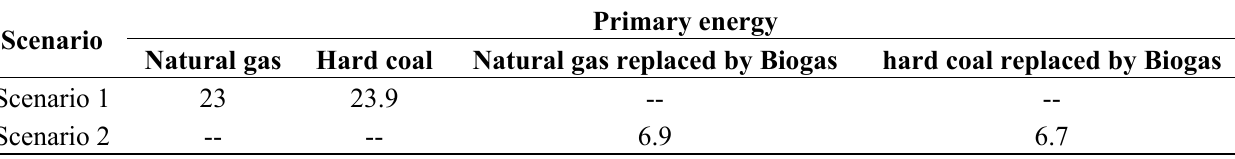
Table 1. Comparison of energy input (MJ/kg-Ethanol) for scenario 1 and